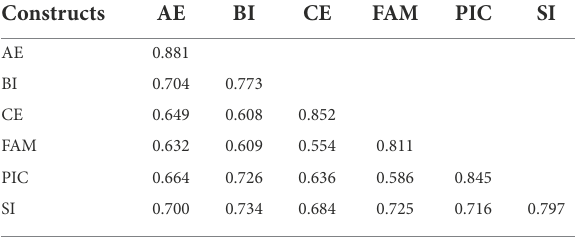
TABLE 4 Discriminant validity: Fornell–Larcker